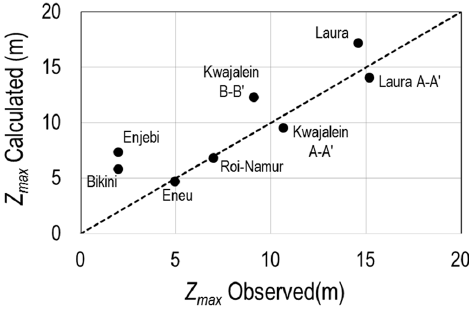
Figure 5. Plot of observed vs. simulated Z max for islands with observation data (see Table 1). Each data point is labeled with the observed lens thickness.